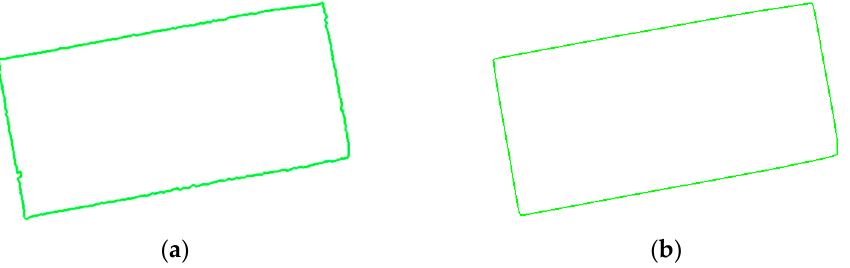
Figure 9. ( a ) Pool edge contour line before regularization; ( b ) pool edge contour line after regularization. The contour lines were imported into Rhinoceros ® v.7 software for the creation of